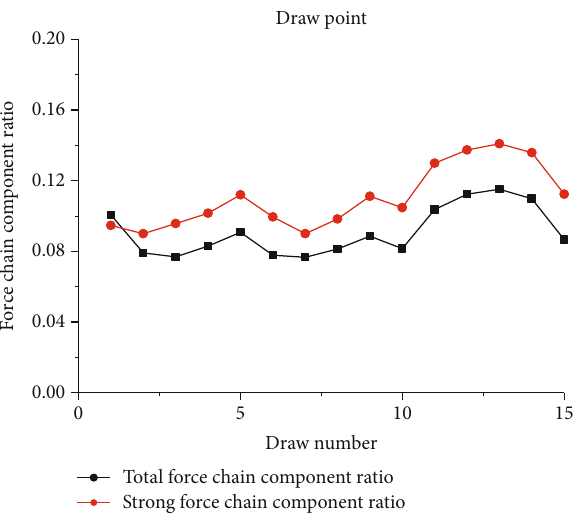
Figure 11: Change law of the component ratios of the force